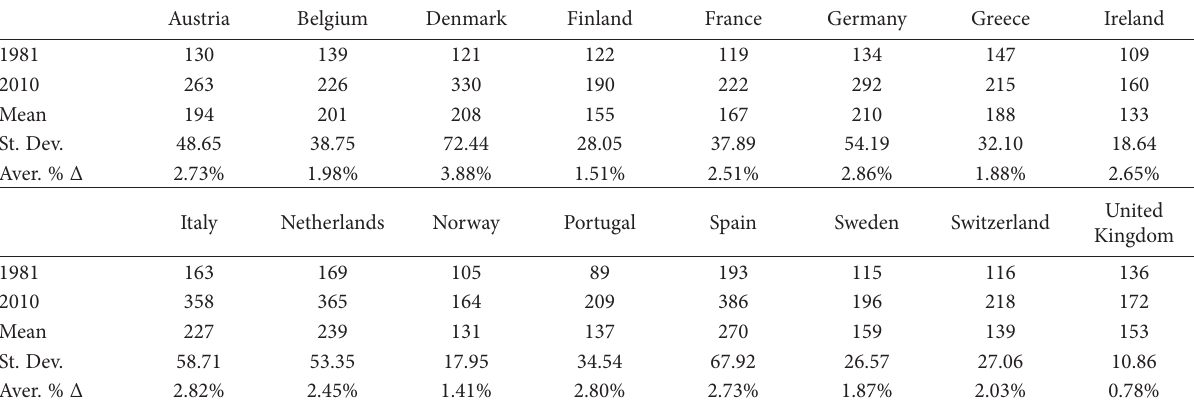
Table 2. Total factor productivity (TFP) (reference level: